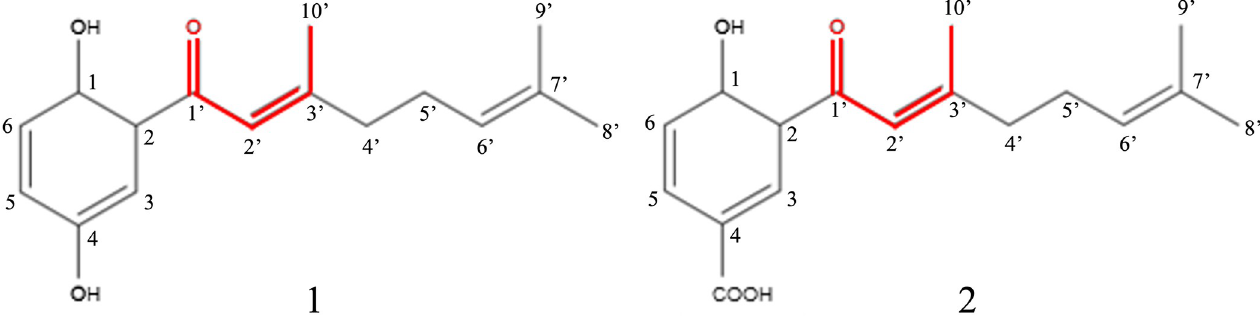
Fig 2. Chemical structures of compounds C1 and C2, isolated from branches of P . crassinervium . The α , β -unsaturated carbonyl system are represented in red.